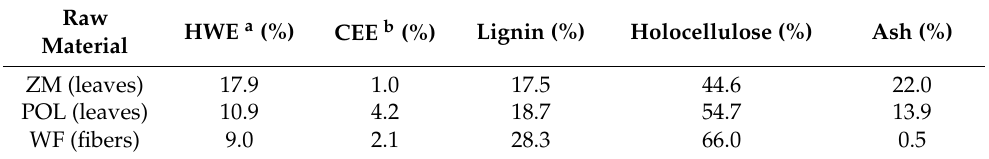
Table 3. Chemical composition of raw lignocellulosic materials.